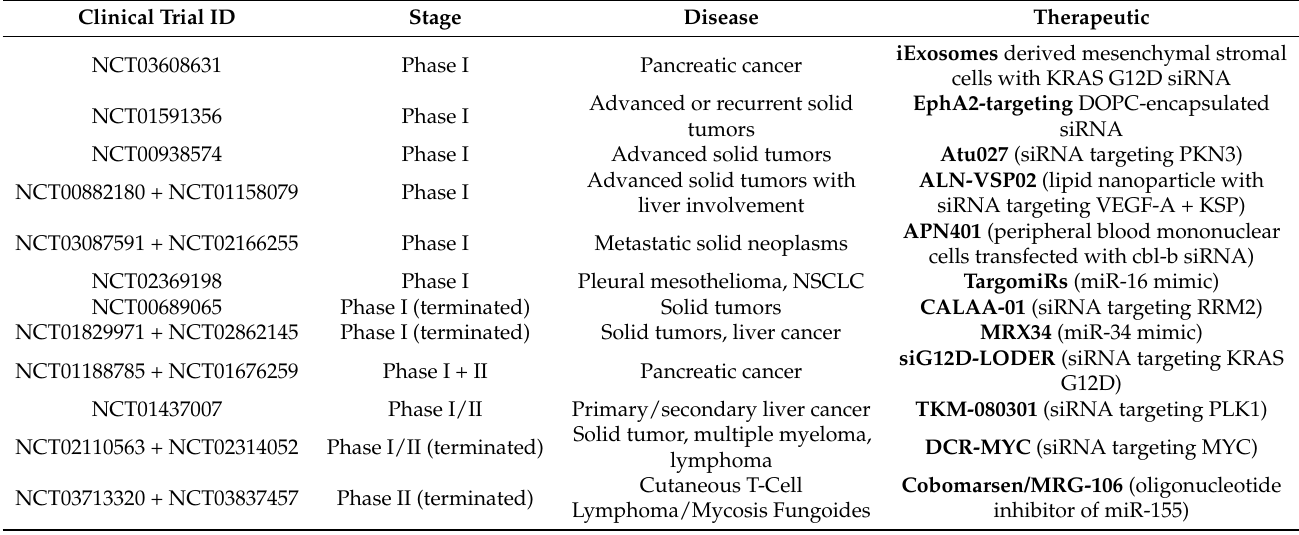
Table 3. Current clinical trials with ncRNA-based